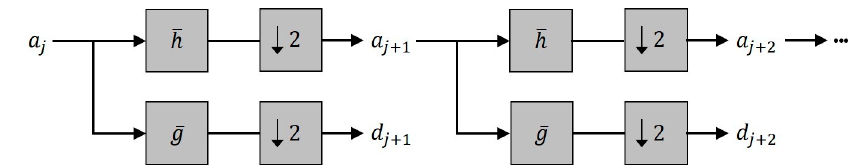
Figure 8. Fast wavelet transform or multiresolution analysis.